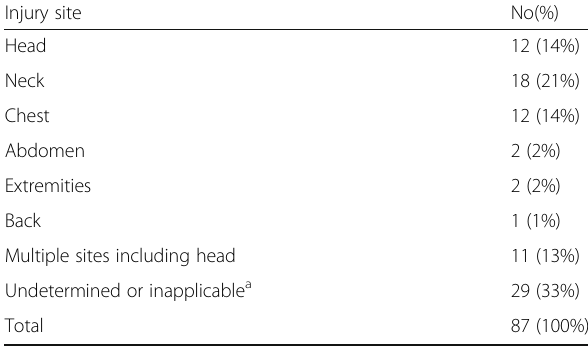
Table 4 Distribution of the injured site in the body